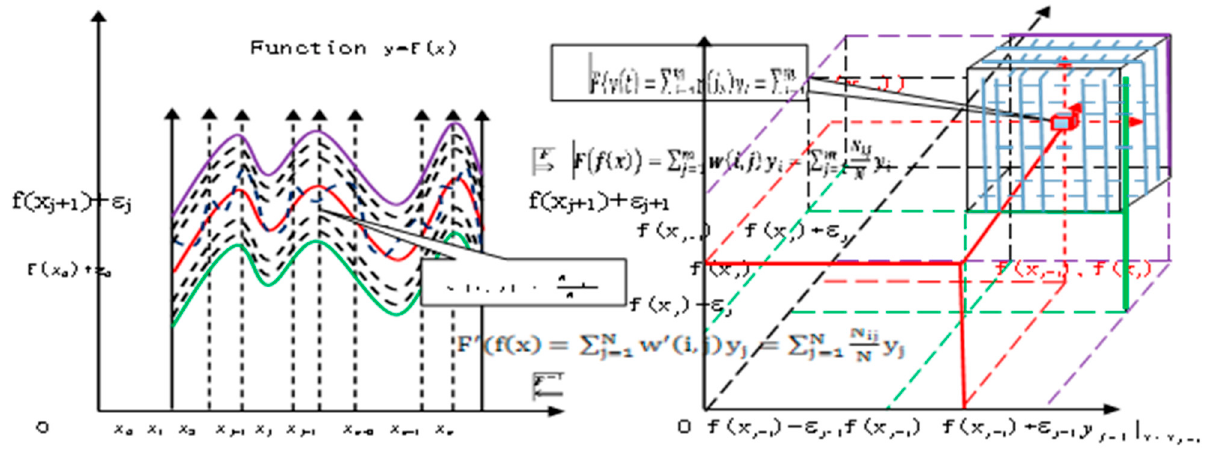
Figure 5. Classification of the normal electrocardiogram ECG by attribute grid computer.